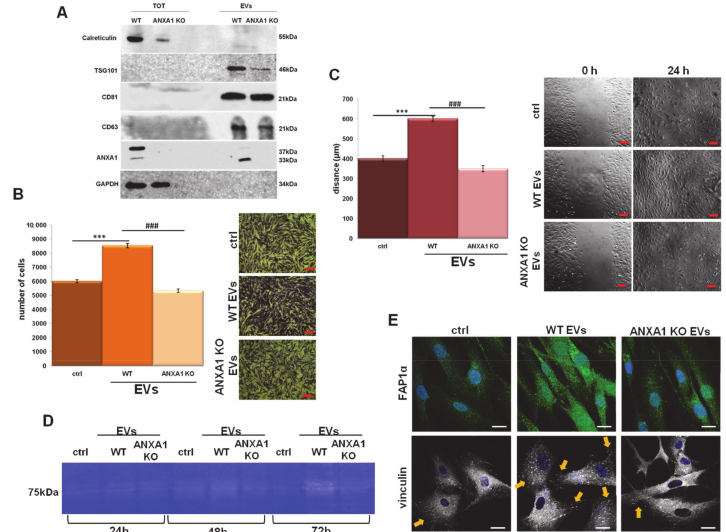
Figure 1. MIA PaCa-2 extracellular vesicles (EV) e ff ects on BJ cells. ( A ) Western blot using antibodies against calreticulin, TSG 101. CD63, CD81, and ANXA1 on the protein content of total cell lysates and EV fractions extracted from the WT and ANXA1 KO MIA PaCa-2 cells. Protein normalization and the check of the sample quality were performed on GAPDH levels. Analysis of ( B ) invasion and ( C ) migration distance of BJ cells treated with EVs from wild type (WT) and ANXA1 knock-out (KO) MIA PaCa-2 cells with relative bright field images. Bar = 50 µ m. ( D ) Gelatin zymography showing increased gelatinolytic activity of MMP-2 of BJ cells. Zymography was performed using 0.1% gelatin gel as described in Section 2, followed by Coomassie blue staining. ( E ) Immunofluorescence analysis to detect Fibroblast Activated Protein 1 α (FAP1 α ) and vinculin. Nuclei were stained with Hoechst 33342 1:1000 for 30 min at room temperature (RT) in the dark. Magnification 63 × 1.4 numerical aperture (NA). Bar = 100 µ m. Data represent the mean of three independent experiments ± standard deviation with similar results. *** p < 0.001 treated cells vs. untreated controls; ### p < 0.001 for each point of ANXA1 KO MIA PaCa-2 cells vs. WT